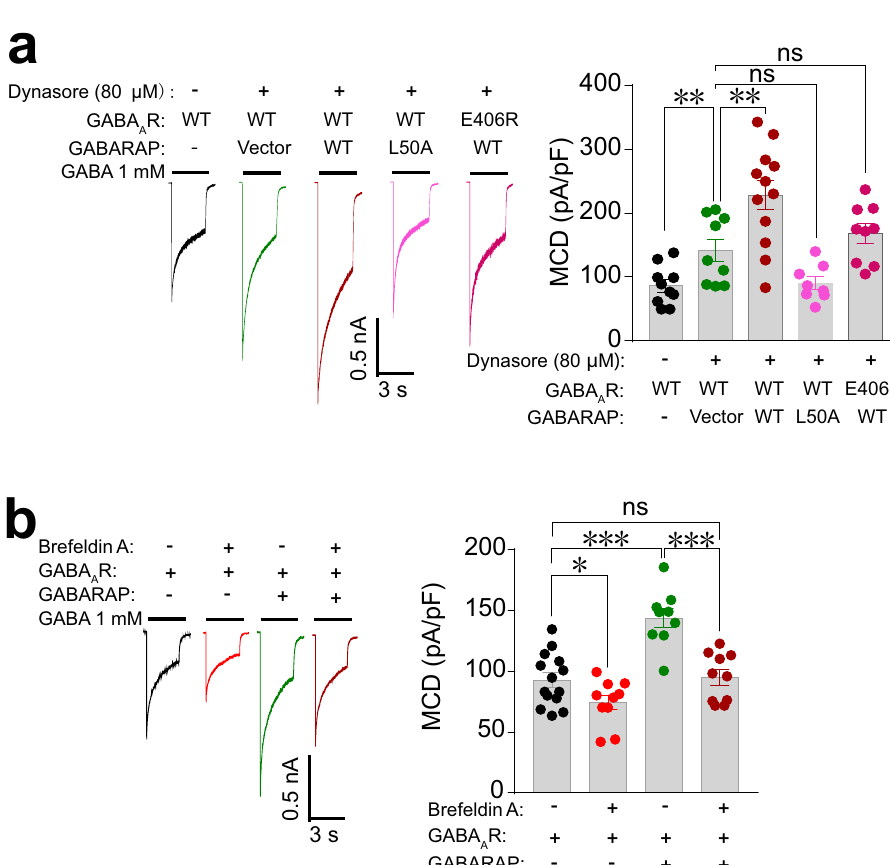
Fig. 5 GABARAP functions to stabilize GABA A Rs via promoting its traf fi cking pathway. a Representative trace records and average values of GABA currents activated by 1 mM GABA in HEK-293 cells co-expressing GABA A R ( α 1 β 2 γ 2) and WT or mutant GABARAP, with or without treatment using the endocytosis inhibitor dynasore (80 μ M, 2 h). n = 10, 9, 12, 8, and 9 of each group (from left to right). Data are represented as the mean ± SEM. ** P = 0.0060, GABA A R vs. GABA A R + Dynasore; ** P = 0.0070, GABA A R + Dynasore vs. GABA A R + GABARAP + Dynasore based on one-way ANOVA; ns, not signi fi cant ( P > 0.05). b Representative trace records and average values of GABA currents activated by 1 mM GABA in HEK-293 cells co-expressing GABA A R ( α 1 β 2 γ 2) and GABARAP with or without treatment of the protein traf fi cking inhibitor Brefeldin A (5 μ g/mL, 30 min). n = 14, 10, 9, and 10 of each group (from left to right). Data are represented as the mean ± SEM. * P = 0.0431, GABA A R vs. GABA A R + Brefeldin A; *** P = 0.0001, GABA A R vs. GABA A R + GABARAP; *** P = 0.0001, GABA + GABARAP vs. GABA + GABARAP + Brefeldin A based on one-way ANOVA; ns not signi fi cant ( P > A R A R